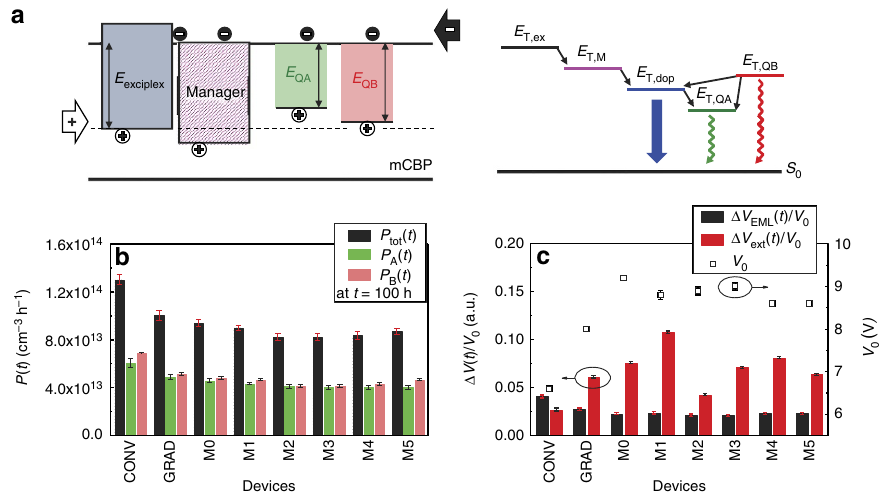
Figure 5 | Analysis of the effectiveness of the manager. ( a ) (Left) Energy level diagram of the doped EML along with proposed positions of Q A and Q B . Here, Q A and Q B are assumed to be hole traps, with Q A deeper in the energy gap than Q B . Holes are transported by the dopant and the manager, and are potentially trapped by Q A and Q B . Electrons are transported by the host and the manager. (Right) Energy diagram of the triplet exciton states in the EML. The sources of triplet excitons in the as-grown device due to charge recombination are twofold: triplet exciplexes ( E T,ex ) generated between the host and the dopant, and triplet excitons directly formed on the manager ( E T,M ). Both can exothermically transfer to the dopant ( E T,dop ). Q A , the deep hole trap, has a low-energy triplet state that results in exciton quenching ( E T,QA ), while Q B , the shallow trap ( E T,QB ), transfers excitons to the lower energy sites. ( b ) Average Q A and Q B generation rates in the EML, P A ( t ) and P B ( t ), from hot states in CONV, GRAD, and managed PHOLEDs. The total defect generation rate is P tot ( t ) where t ¼ 100h. ( c ) Relative contributions to the voltage rise with respect to V 0 induced by defects within and outside the EML (that is, Q A þ Q B and Q ext , respectively) at t ¼ 100h. The separate contributions to the voltage rise, D V EML ( t )/ V 0 and D V ext ( t )/ V 0 , along with V 0 are shown. Error bars represent one s.d. for at least three devices.